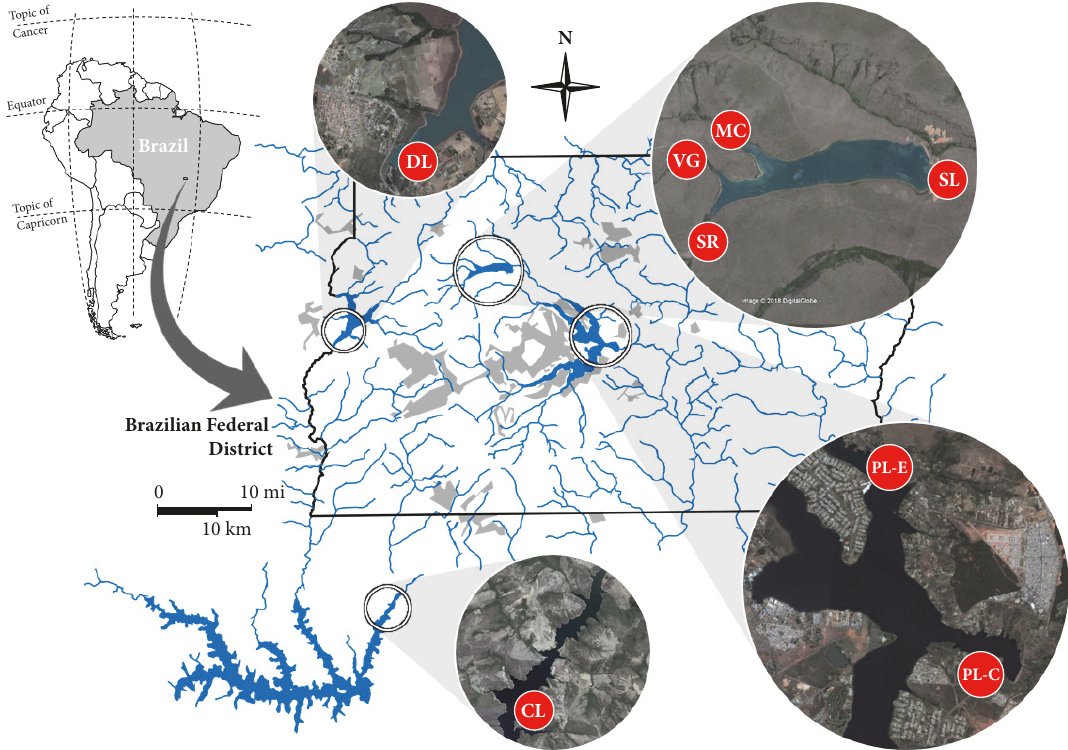
Figure 1: Map showing the Federal District in Brazil and the sampling points selected. DL: Descoberto Lake, SL: Santa-Maria Lake, SR: Santa-Maria River, VG: Vargem-Grande Stream, MC: Milho-Cozido Stream, CL: Corumb´a Lake, PL-C: Parano´a Lake (conventional uptake), and PL-E: Parano´a Lake (emergency